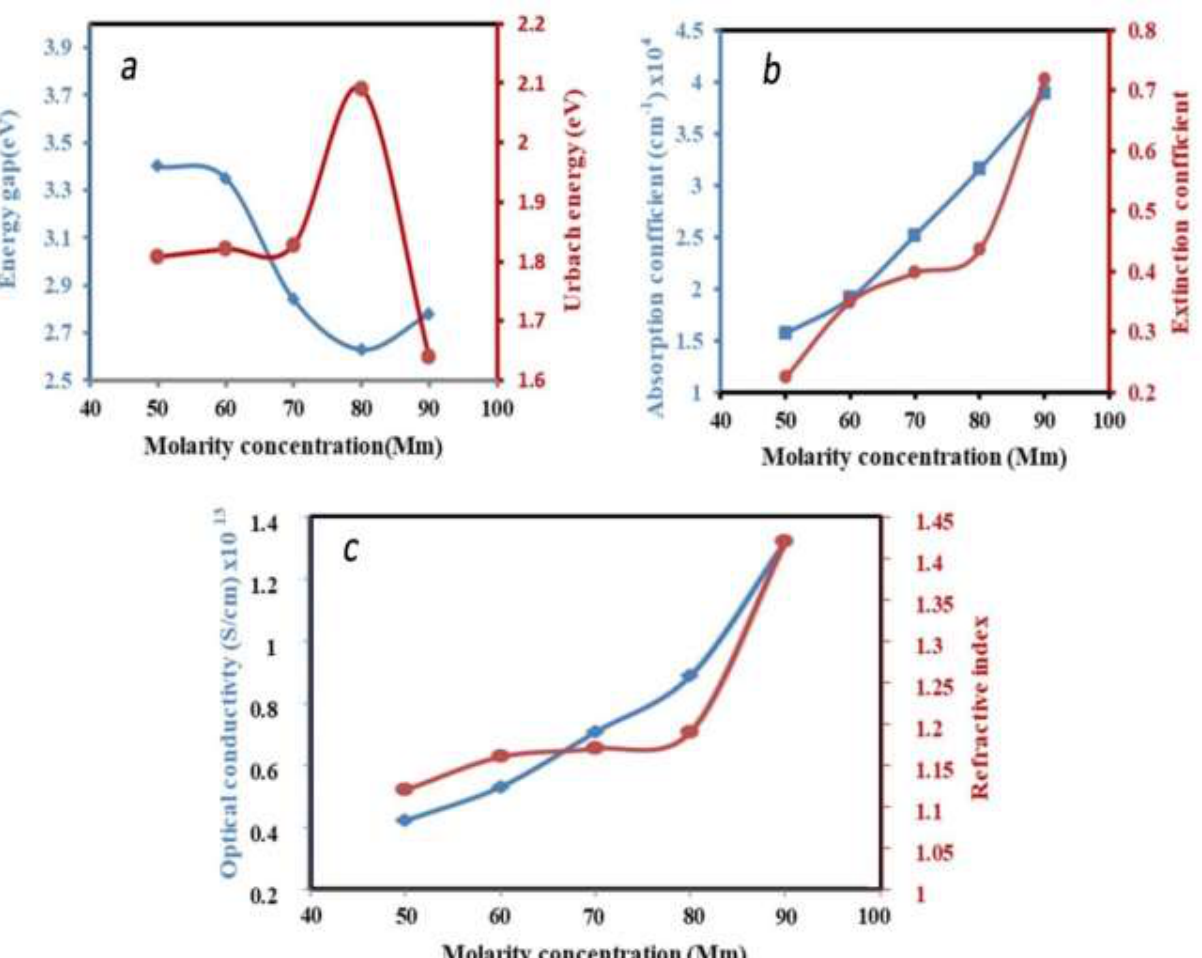
coefficient of absorption, extinction coefficient, optical conductivity, and refractive index of tungsten oxide films concentrations from 50 mM to 90mM, because of the improved impact of electron transitions between both the reducing the energy gap [4]. Due to improved density of packing and layer thickness with a reduced extinction coefficient, the refractive index(n) value improved steadily, increasing molarity concentration [4]. Figure 2: Variation of an optical parameter versus various molarity concentrations, a. Energy gap and Urbach energy, b. absorption coefficient and Extinction coefficient, and c. optical conductivity and Refractive index. For many materials, the absorption coefficient (α) near the band ledge is thought to have an exponential relationship with photon energy hυ. The relationship derived from Urbach explains this reliance [55].